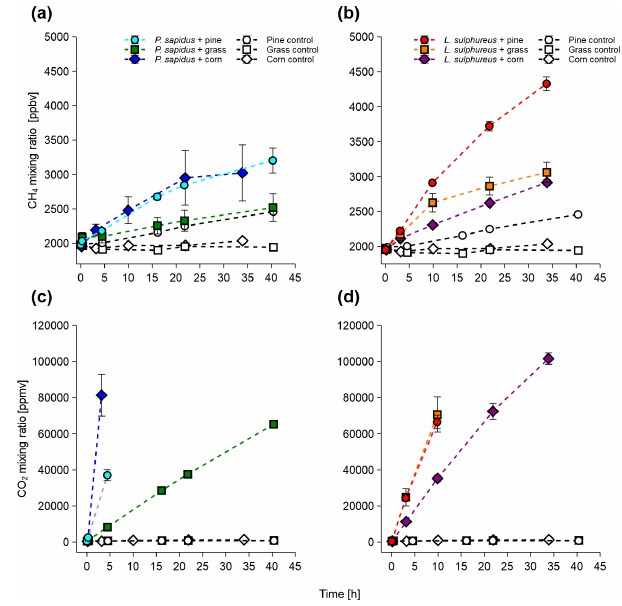
Figure 1. Mixing ratios of CH 4 and CO 2 of P. sapidus (a, c) and L. sulphureus (b, d) grown on pine wood, grass, and corn. Mixing ratios are presented as mean values with their standard deviation ( n =